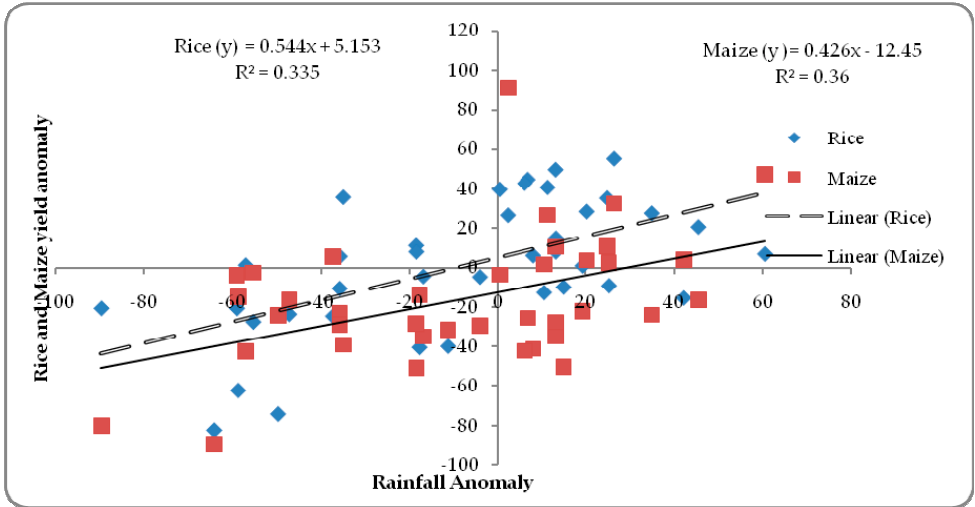
Figure 4. Correlation coefficients (r) values for rice and maize yield anomaly, along with rainfall Figure4. Correlationcoe ffi cients(r)valuesforriceandmaizeyieldanomaly, anomaly.